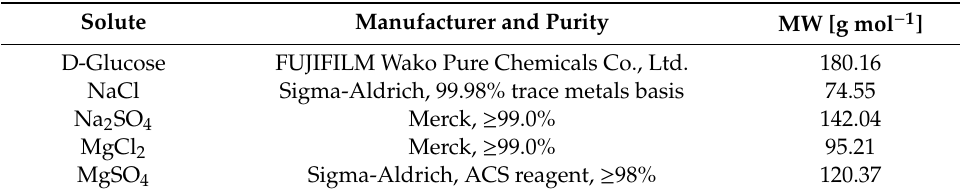
Figure 3. A diagram of the liquid permeation apparatus. Table 1. Solutes utilized for the liquid permeation test.